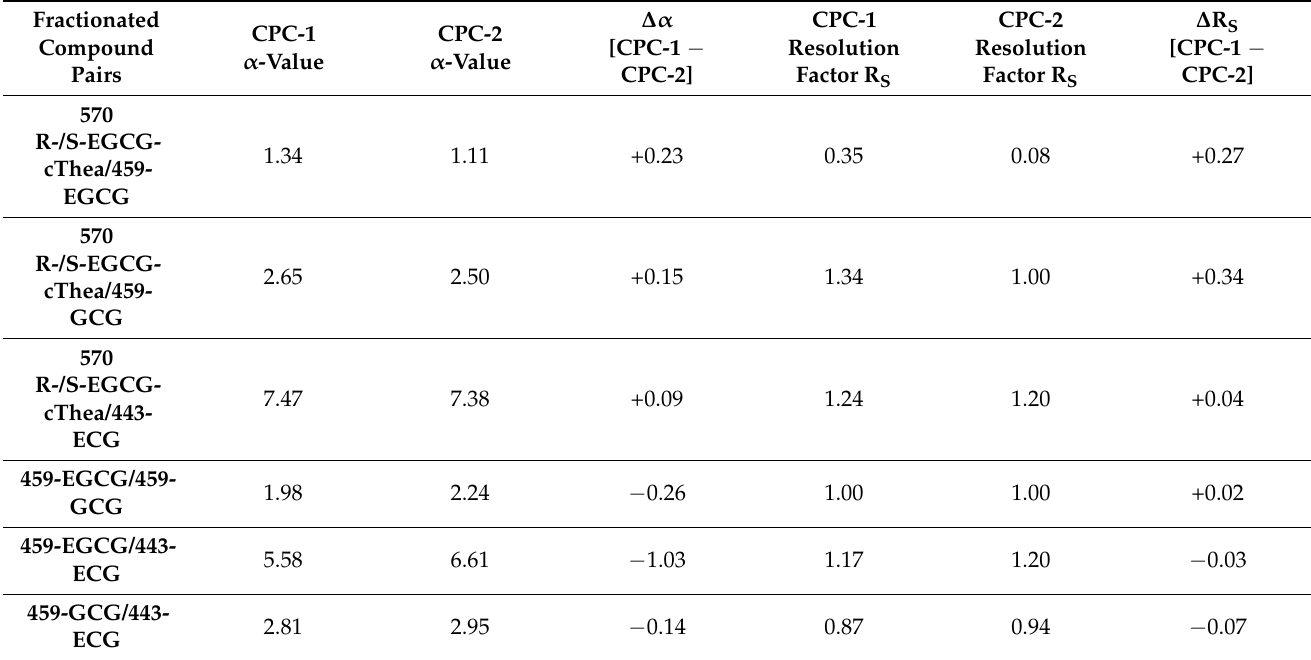
Table 2. Comparison of values of separation factor α and resolution factor R S of metabolite pairs from semi-preparative CPC-1 and